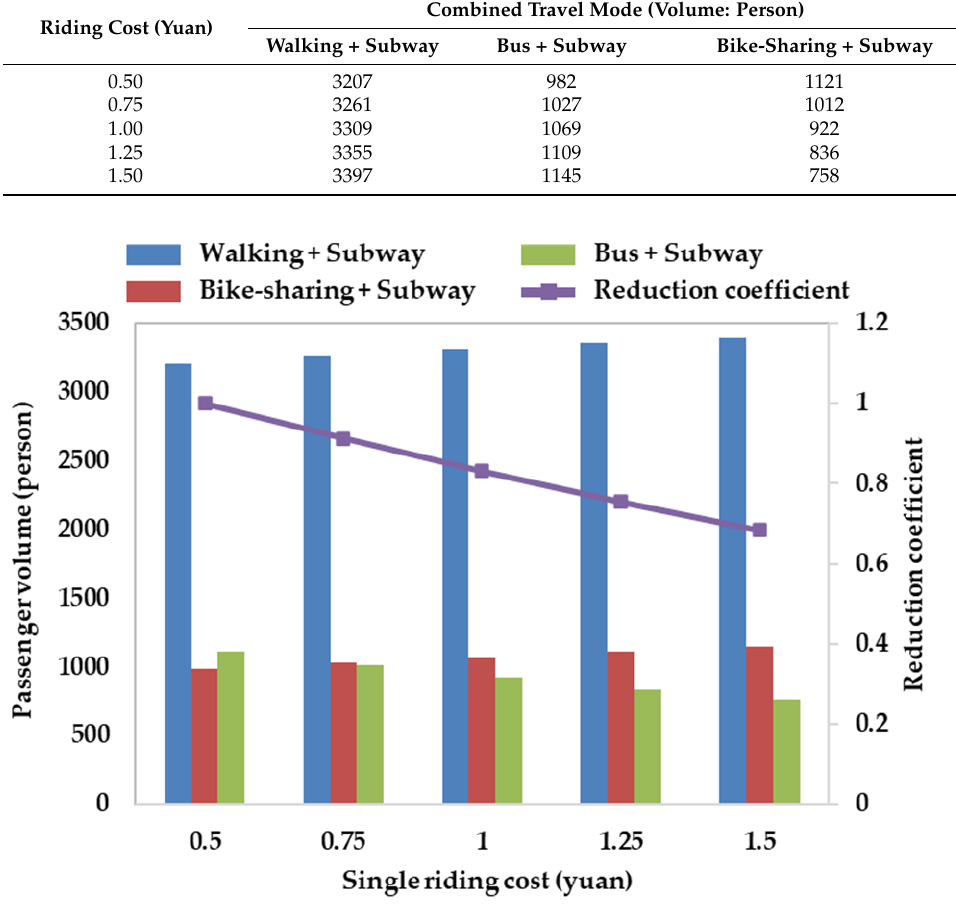
Figure 9. Sensitivity analysis of single ride cost .